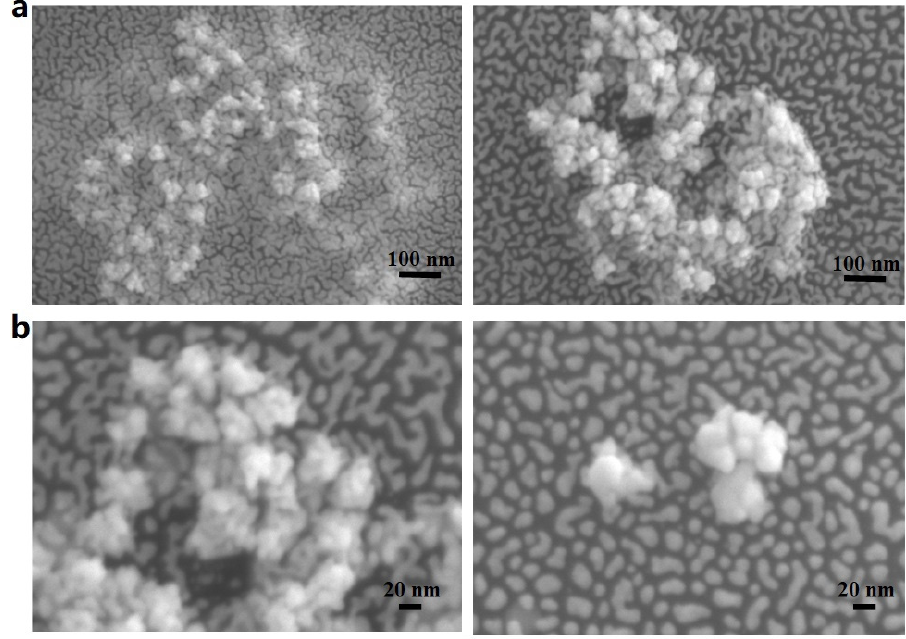
Figure 4. SEM images of P-GERTs: ( a ) 100 KX magnification; ( b ) 200 KX magnification.